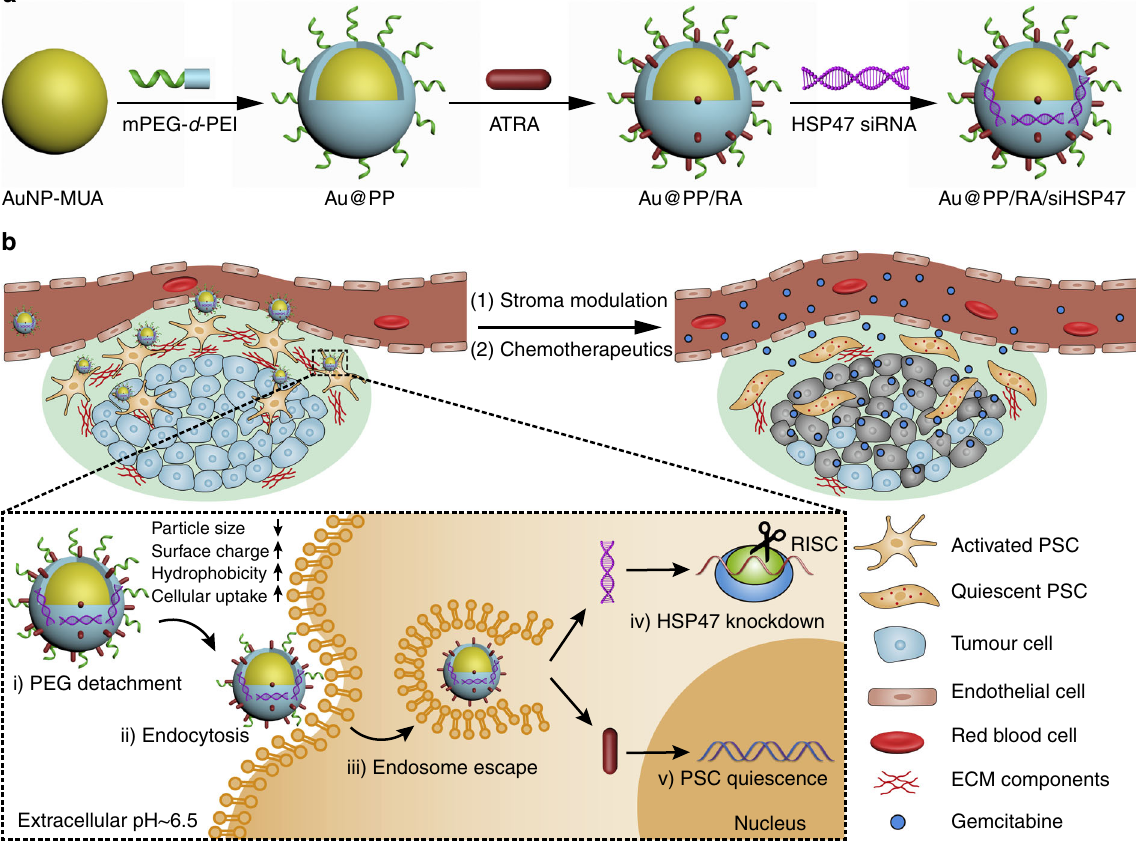
Fig. 1 Scheme of homoeostatic restoration of pancreatic desmoplastic stroma. a Schematic diagram of the fabrication of the ATRA and HSP47 siRNA co- delivery system based on pH-responsive gold nanoparticles. Anionic ATRA and siRNA were electrostatic absorbed onto “ sheddable ” PEG-grafted polyethylenimine (PEI)-coated gold nanoparticles. b Schematic diagram of PSCs re-education and stroma modulation by the nanosystem. The nanosystem is “ activated ” (PEG shedding, size decrease, charge increase, and hydrophobic ligand exposure) in the acidic pancreatic tumour microenvironment (pHe ~6.5) and exhibits pHe and ATRA dual-enhanced cellular uptake and HSP47 knockdown in PSCs. Consequently, activated PSCs revert to quiescent phenotype and the desmoplastic stroma is homoeostatically restored, with improved blood perfusion and drug